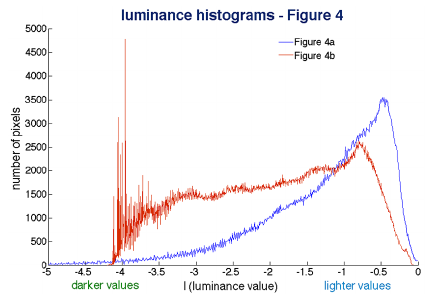
Figure 6: Luminance histograms of images in Figure 4.